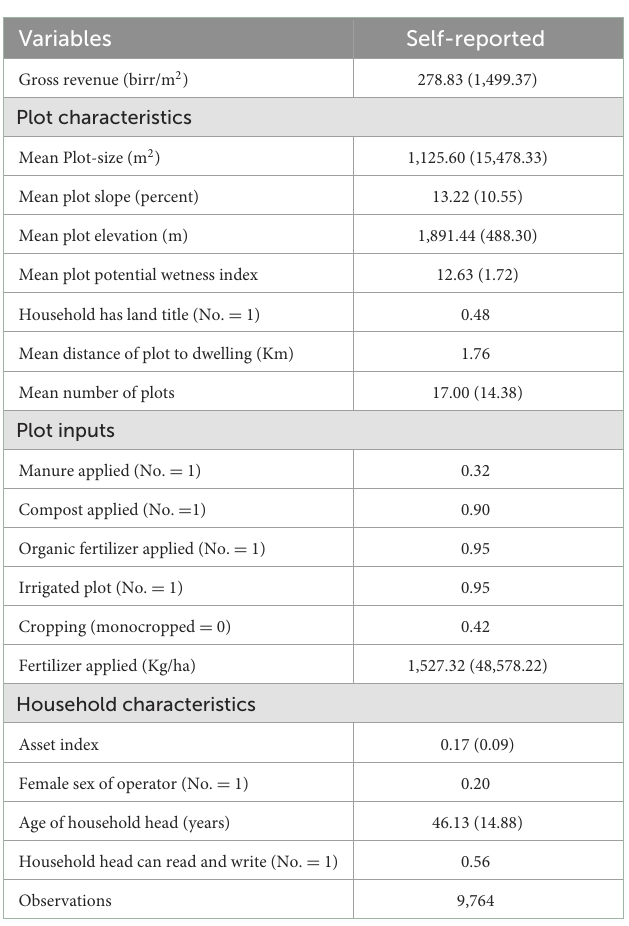
TABLE 2 Farm-houshold attributes, self-reported, all